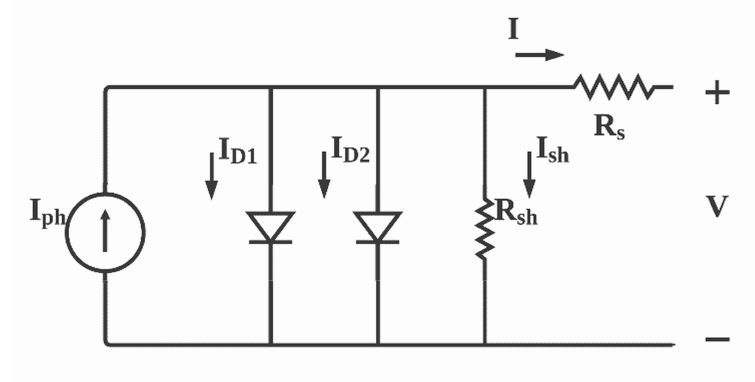
Figure 2. Double diode model of solar